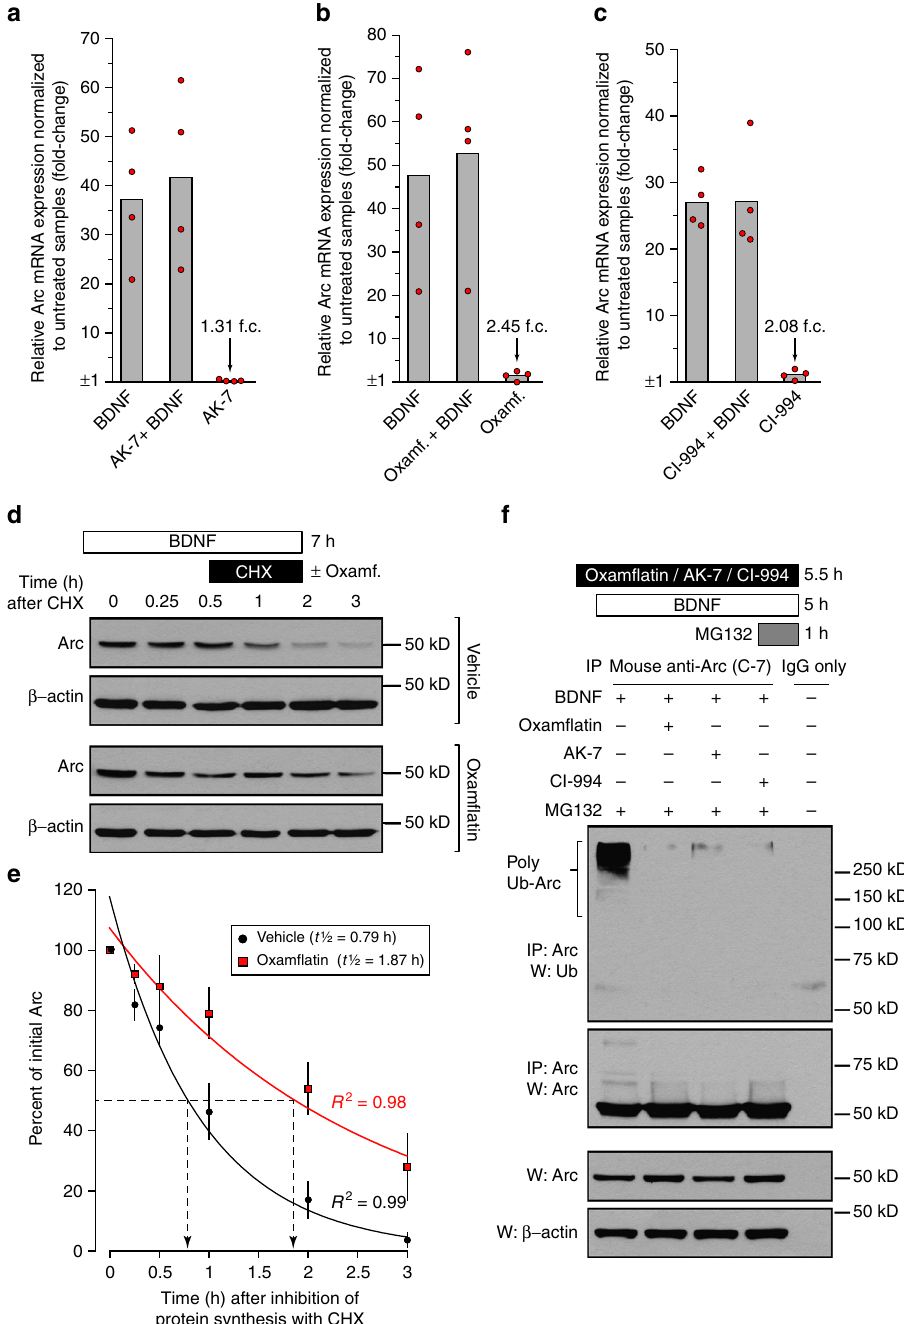
Fig. 5 KDAC inhibitors AK-7, oxam fl atin, and CI-994 in fl uence Arc protein stability and ubiquitination but not transcription. a – c Arc mRNA levels were assessed by quantitative real-time PCR in primary cortical neuron cultures treated for 6 h with AK-7 ( a ), oxam fl atin ( b ), or CI-994 ( c ). Each compound was tested at a concentration of 16.7 µ M and in combination with BDNF or alone. Arc mRNA level induced by just BDNF was included in each experiment as a reference. Bars represent mean fold-change (f.c.) normalized to Arc expression measured in untreated cultures and each red point represents fold-change for an individual biological replicate ( n = 4). d Primary cortical neurons were treated with BDNF for 4 h to induce Arc expression at which point protein synthesis was blocked by direct addition to culture media of cycloheximide (CHX, 50 µ g ml − 1 ) in presence of vehicle or oxam fl atin (16.7 µ M). Lysates were collected at the indicated time points and Arc protein level in every sample was analyzed by western blot and normalized to corresponding β -actin. e Each data point from d is represented as mean ( ± SEM) calculated from fi ve biological replicates and is presented as percentage of Arc level at the initial time point after CHX application ( t = 0). Arc protein half-life was estimated by exponential decay curve fi t. f Arc polyubiquitination was determined in lysates from primary cortical neurons cultured for 6 h with BDNF alone or BDNF plus oxam fl atin, AK-7, or CI-994 (compounds fi nal concentration = 16.7 µ M). Lysates were immunoprecipitated with anti-Arc and western blotted with anti-Ub or anti-Arc as indicated. The proteasome inhibitor MG132 (10 µ M) was added for 1 h before preparation of lysates to allow accumulation of polyubiquitinated